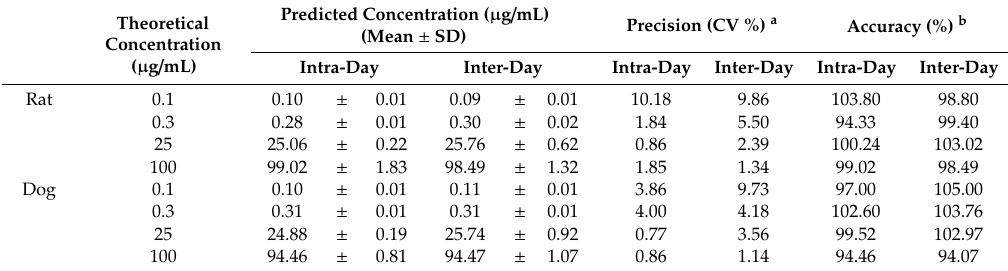
Table 1. Intra- and inter-day precision and accuracy for the LC-MS / MS method to determine THAP in rat and dog plasma ( n =